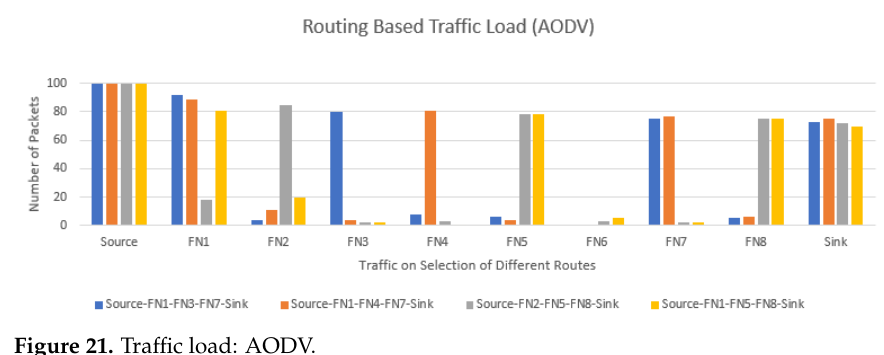
Figure 21. Traffic load: AODV.